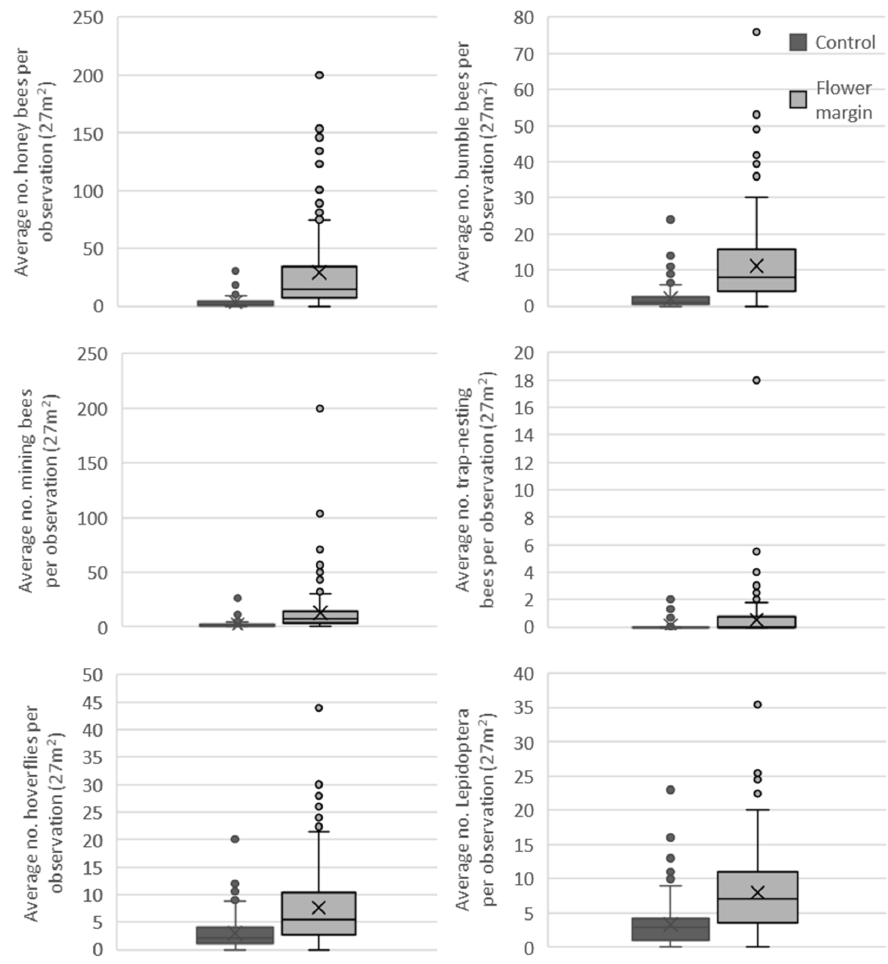
Figure 1. The average number of different pollinator groups observed in a 27 m 2 area (3 observations in a transect of 3 × 3 m) of control field margins and those planted with an Operation Pollinator seed mix (flower margin). The boxes are the interquartile range, the line in the box is the median and the cross is the average. The whiskers are 1.5 times the interquartile range and the dots are data points that fall outside that range.